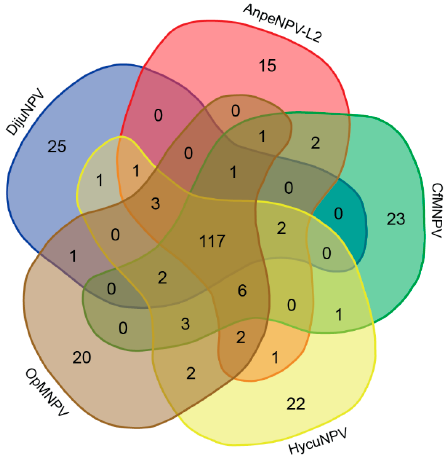
Figure 4. Venn diagram comparing the gene content among DijuNPV and some selected relatives. Total number of genes of the five alphabaculovirus (DijuNPV, AnpeNPV ‐ L2, CfMNPV,